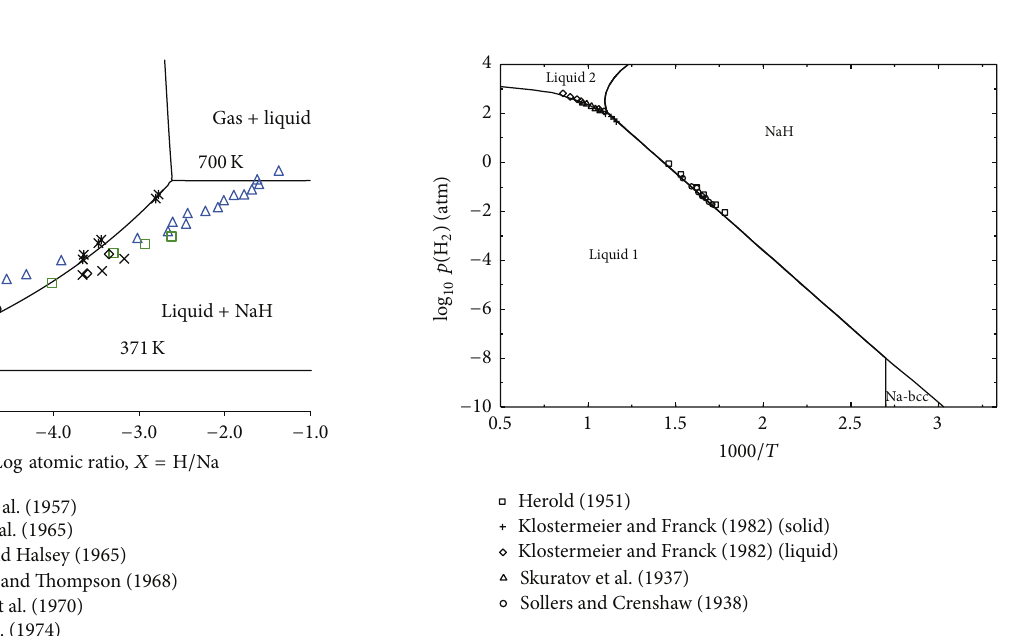
Figure 7: Calculated dissociation pressure of NaH in comparison with the experimental data from the literature.